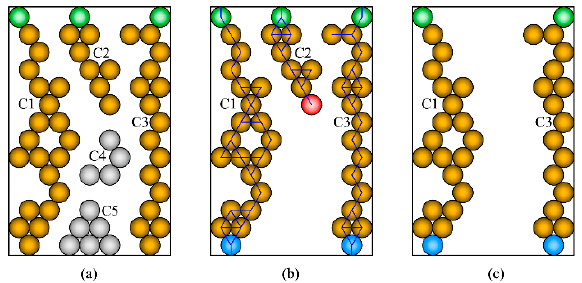
p . ( a ) all of the clusters. ( b ) all of the clusters el